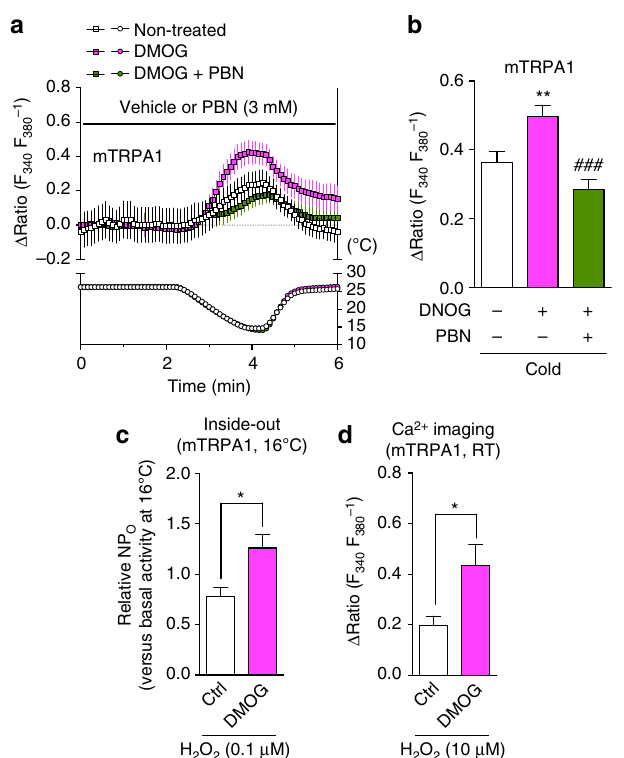
Figure 3 | PHD inhibition augments cold-induced activation of mTRPA1 via an enhanced response to ROS. mTRPA1-expressing cells were exposed to cold ( a – c ) or 10 m M H 2 O 2 ( d ) and analysed using Ca 2 þ imaging experiments or inside-out patch-clamp recordings. ( a ) Representative traces of cold-induced [Ca 2 þ ] i responses in mTRPA1-expressing cells pretreated with or without DMOG (100 m M) for 2h ( n ¼ 8–19 cells) in the presence or absence of 3mM PBN, and ( b ) statistical analysis ( n ¼ 39–96 cells). ** P o 0.01 versus non-treated mTRPA1 (white bar); ### P o 0.001 versus DMOG-pretreated mTRPA1 (magenta bar); one-way ANOVA with Tukey’s post hoc test. ( c ) Relative open probability (NP O ) of mTRPA1 in inside-out patches in the presence 0.1 m M H 2 O 2 at 16 (cid:2) C from a mTRPA1- expressing cell pretreated with or without DMOG (100 m M) for 2h. n ¼ 8–11. * P o 0.05; unpaired t test. Membrane potential was (cid:2) 60mV. ( d ) Statistical analysis of the H 2 O 2 -evoked [Ca 2 þ ] i responses in mTRPA1- expressing cells pretreated with or without DMOG (100 m M) for 2h. n ¼ 10–12. * P o 0.05; unpaired t test. All data are expressed as mean ± s.e.m.